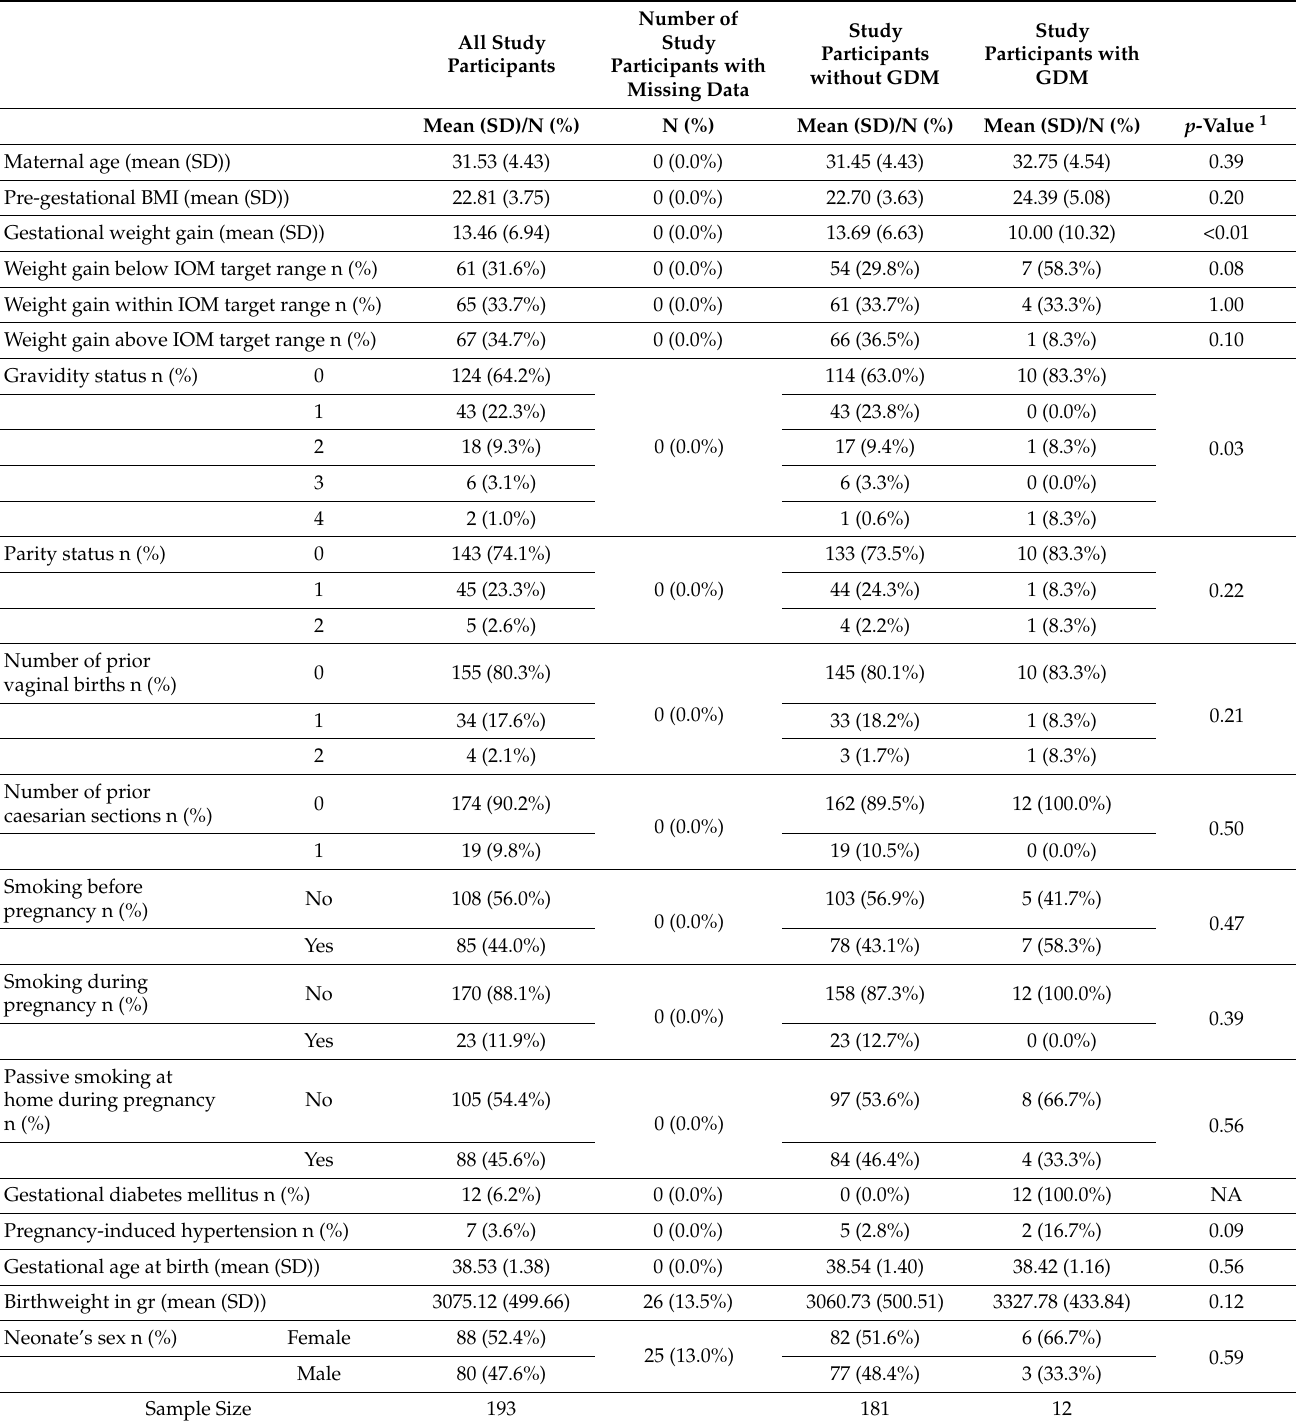
Table 1. Maternal and neonatal baseline characteristics for total study population and per GDM